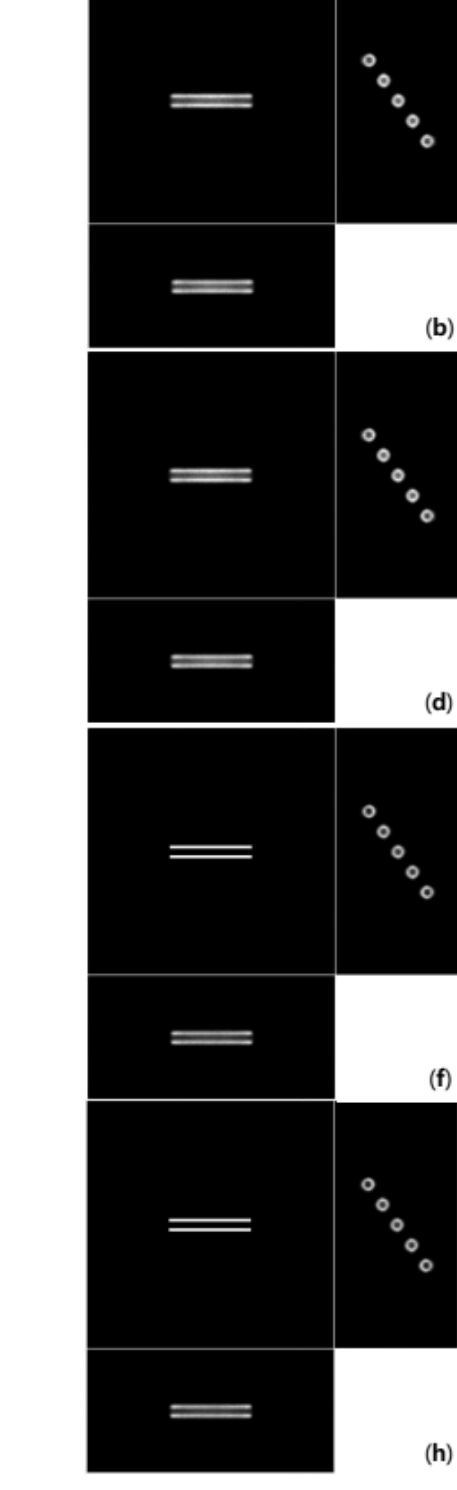
Figure 7. Deconvolution results using the ( a ) depth-invariant symmetric OSL algorithm, ( b ) depth-invariant symmetric GEM algorithm, ( c ) depth-variant symmetric OSL algorithm, ( d ) depth-variant symmetric GEM algorithm, ( e ) depth-variant symmetric OSL algorithm, ( f ) depth-variant asymmetric GEM algorithm, ( g ) depth-variant asymmetric OSL algorithm, and ( h ) depth-variant asymmetric GEM algorithm on the 10 dB Gaussian noise